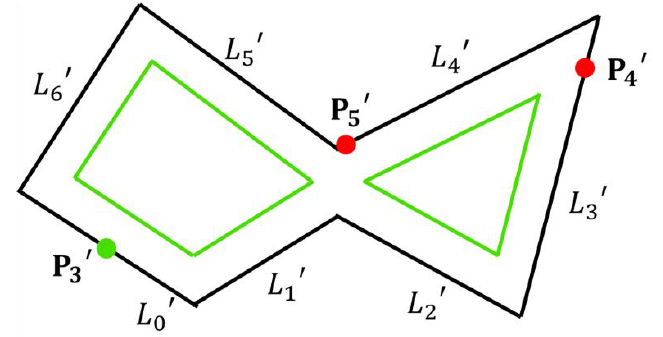
Figure 10. Judgment of the invalid points.